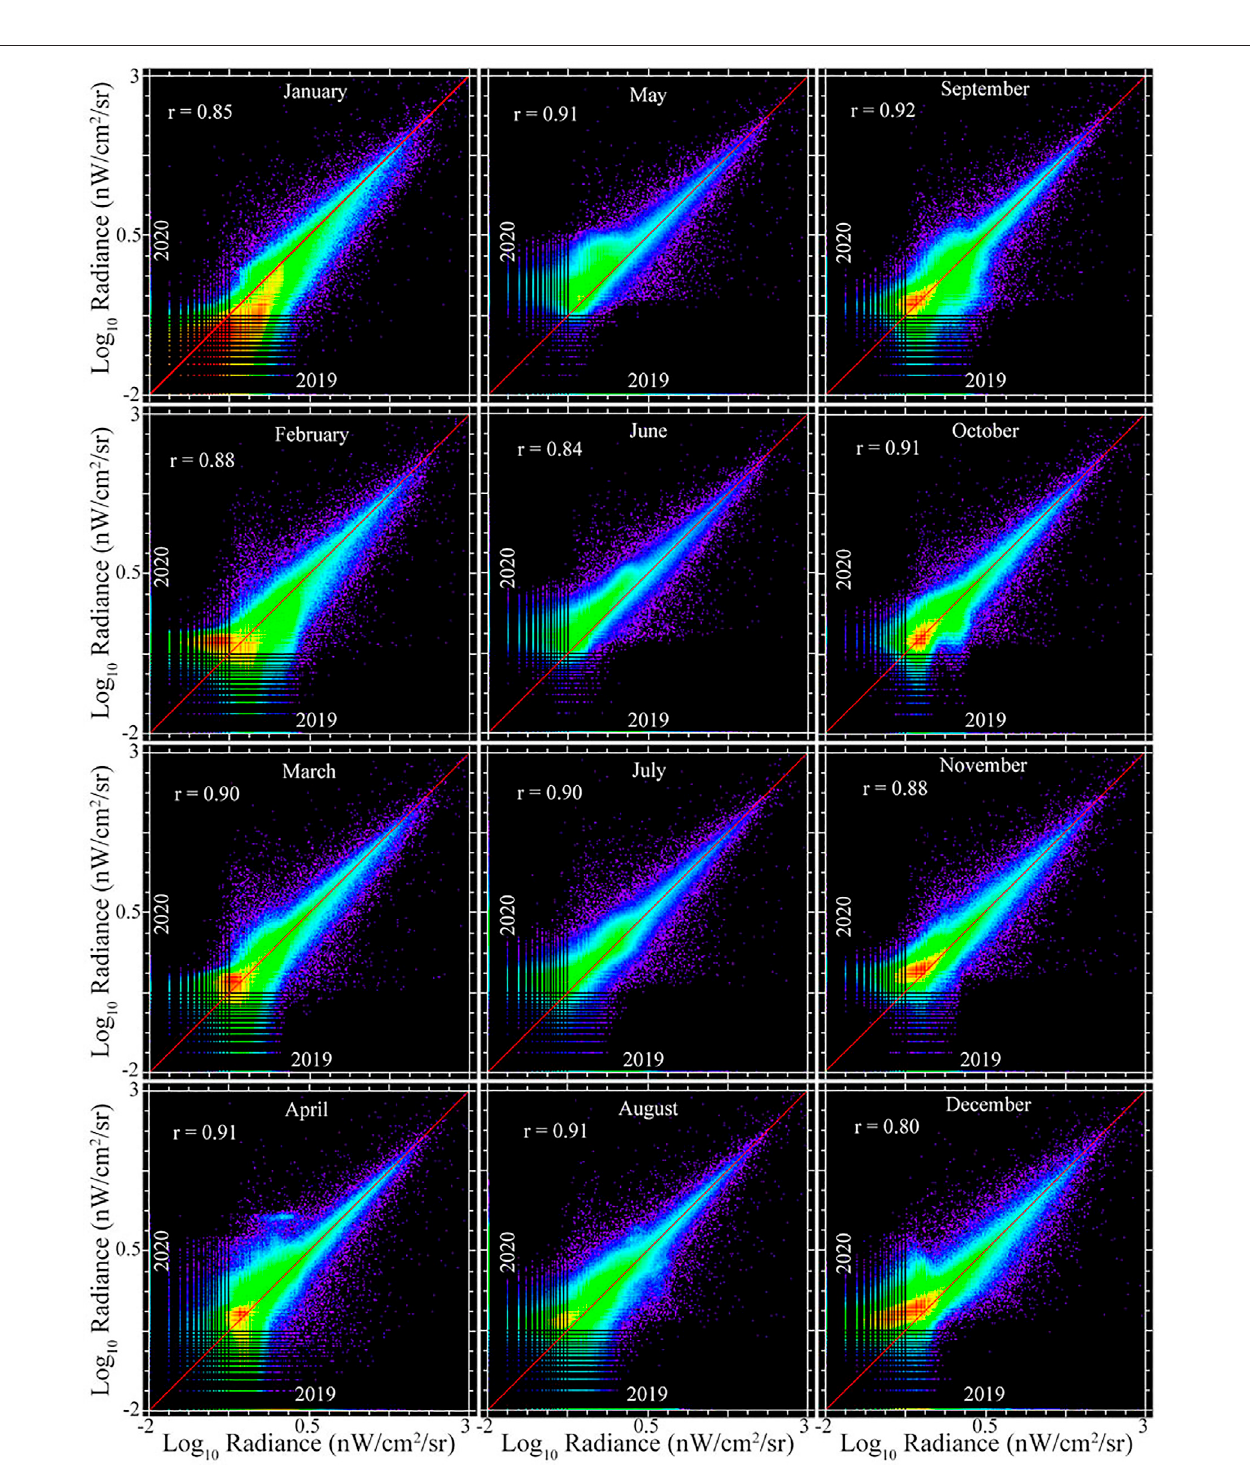
FIGURE3| Monthlycomparisonsof2019and2020forEurasia.Inallmonths,dispersionaboutthe1:1linediminisheswithincreasingbrightness,withnoapparent bias above ∼ 100.5 nW/cm 2 /sr. At lower brightness levels, there is considerable bias, varying from month to month. Brighter sources show slight bias suggesting dimming from 2019 to 2020 in January and March, but none apparent in other months. Correlations computed using only radiances > 10 +0.5 nW/cm 2 /sr.